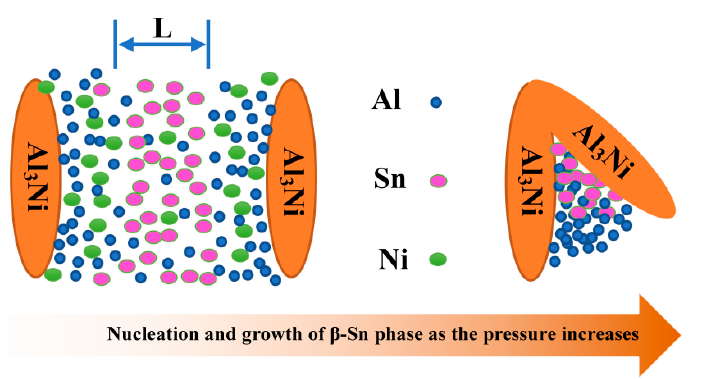
Figure 4. Schematic diagram of the growth of β -Sn phase at different